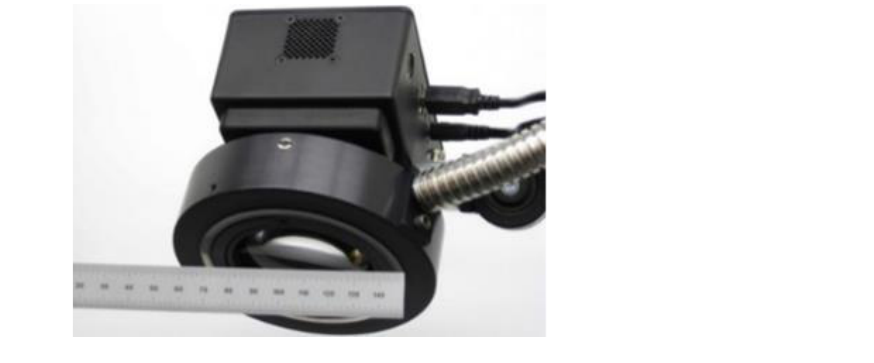
Figure 25. The complete multispectral camera, including the objective assembly and integrated ring illuminator.